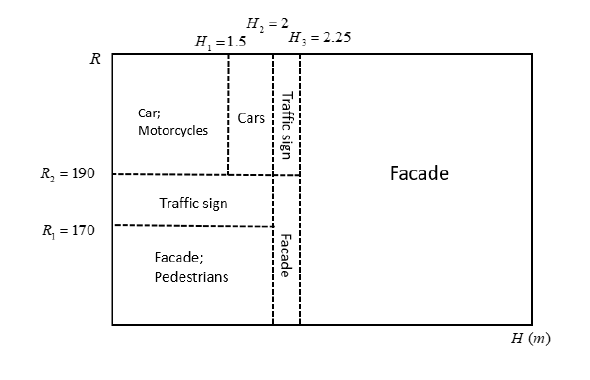
Figure 3. Two-dimensional feature space.